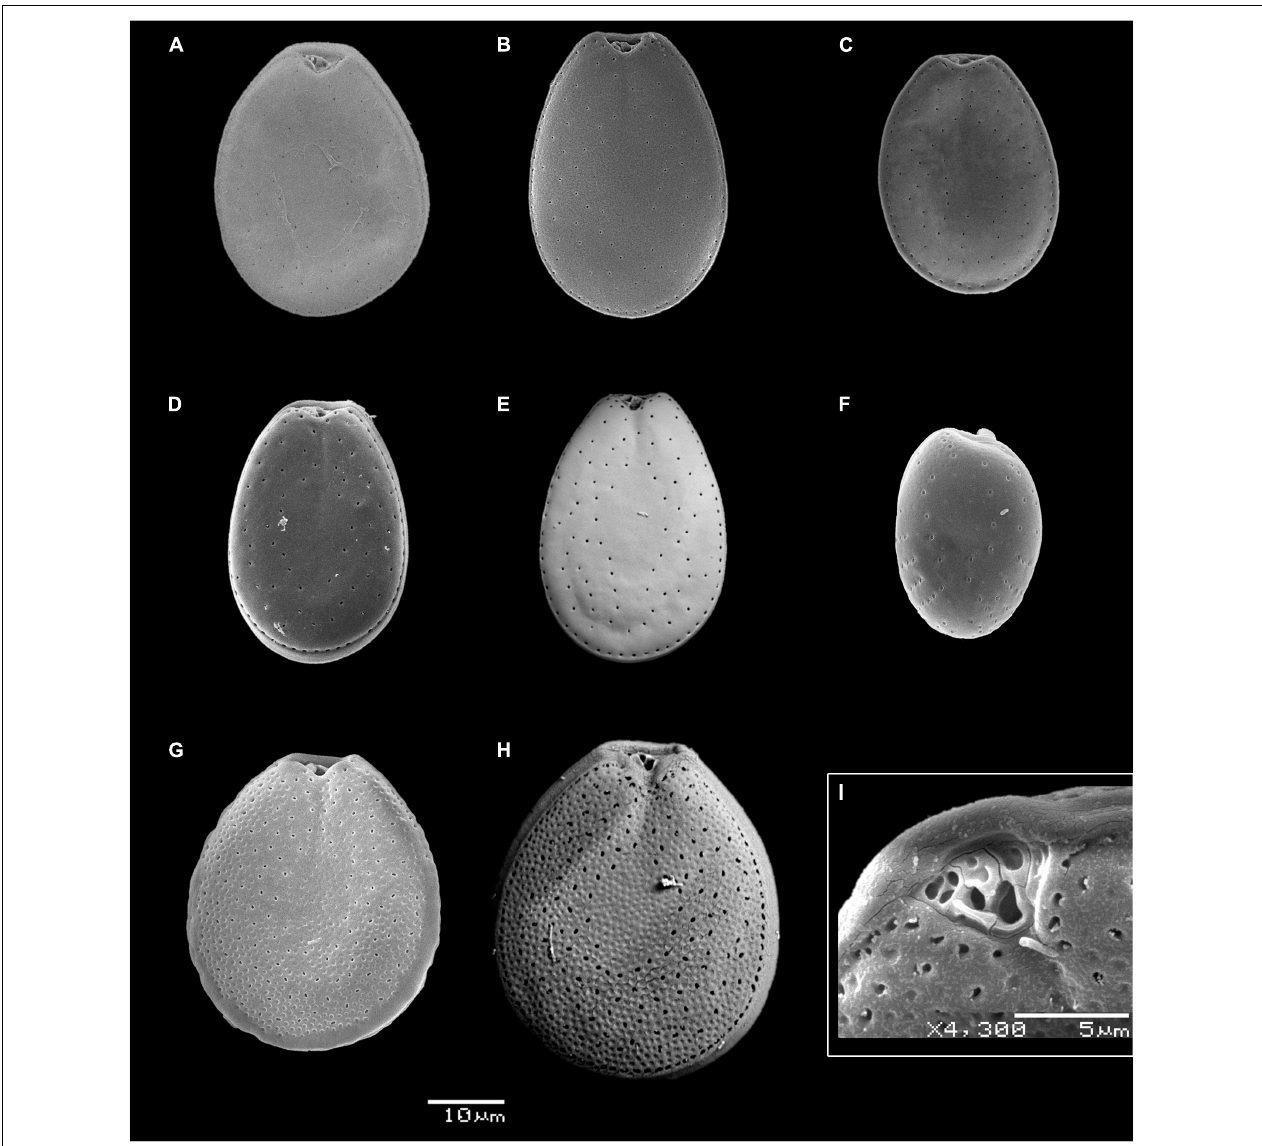
FIGURE 3 | Scanning electron micrographs of selected isolates of Prorocentrum species as representative for major clades: (A–E) P. lima morphotypes (PLSC) (PA1, PA8, PA9, PA48, and PA72, respectively) in right view; (F) P. rhathymum (PA20) in left thecal view; (G–I) P. hoffmannianum (PA89 and PA70); panels (G,H) in right thecal view; panel (I) in right lateral-apical view. Panel (I) shows a typical platelet arrangement and the two pores in the periflagellar area; numbering/lettering system for the platelets and pores in the periflagellar area: (e.g., ap–accessory pore, fp–flagellar pore) is according to Hoppenrath et al. (2013). Scale bars: 10 µ m in Panels (A–H) and 5 µ m in panel (I)